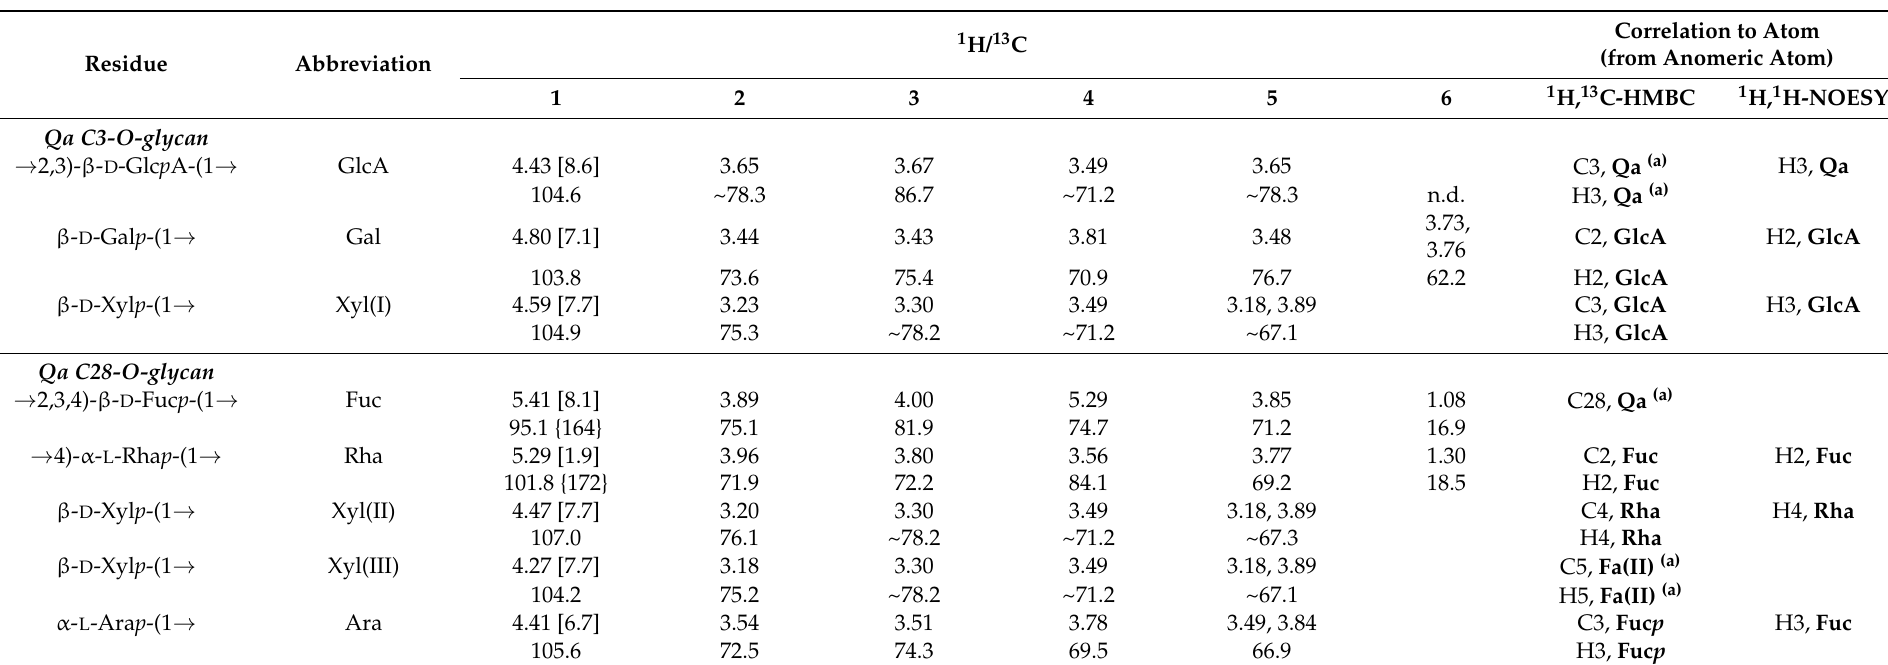
Table 1. 1 H and 13 C NMR chemical shifts (ppm) of the two oligosaccharide chains from Qb1 , and inter-residue correlations from 1 H, 1 H-NOESY and 1 H, 13